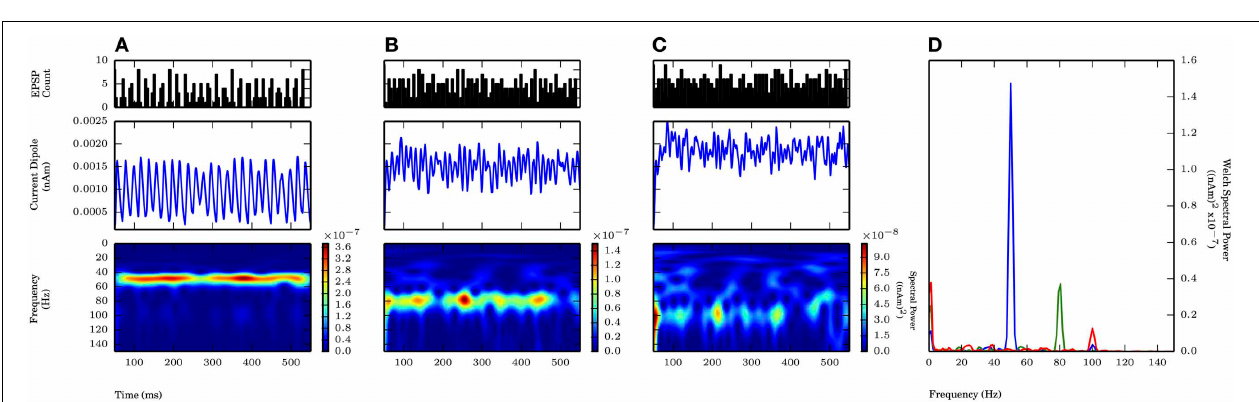
FIGURE 7 | Faster subthreshold oscillations break down at fixed standard deviation. Subthreshold oscillations generated similarly as in Figure 6 . Fixed σ p of 2.5 ms. As frequency of input ( f prox ) increased, the spectral power decreased. (A) f prox = 50Hz: Same as Figure 6A. Max. P W of 1.4 × 10 − 7 (nAm) 2 (blue in D ). (B) f prox = 80Hz: Less consistent band of activity at 80Hz, compared to 50Hz